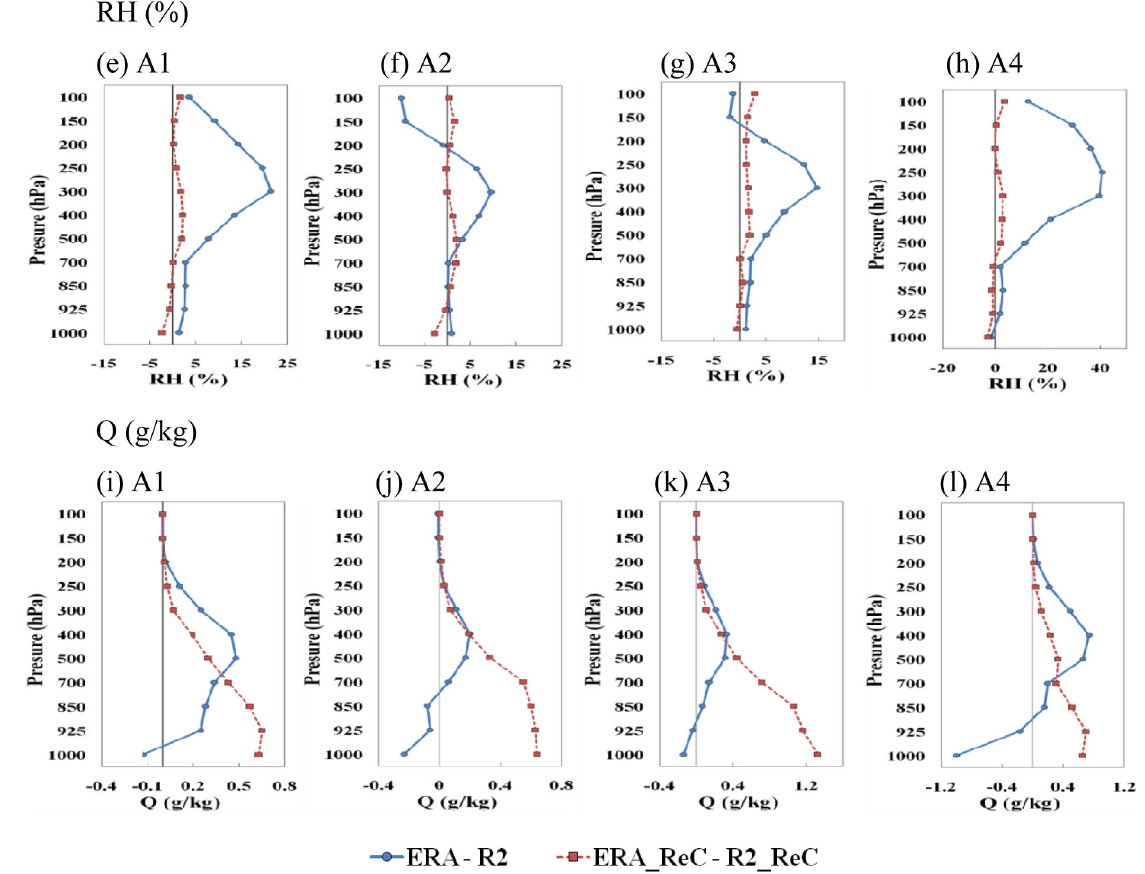
Figure 7. Vertical profiles of 20-year summer averaged differences between the ERA and R2 datasets ( blue ), and between the ERA_ReC and R2_ReC simulations ( red ) over the selected sub-areas (see Figure 1) for three selected climate elements (temperature ( a – d ), RH ( e – h ) and Q ( i – l